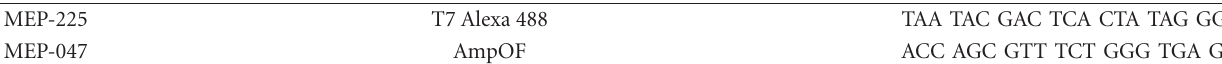
Table 4: FCS fragment amplification primers (Section